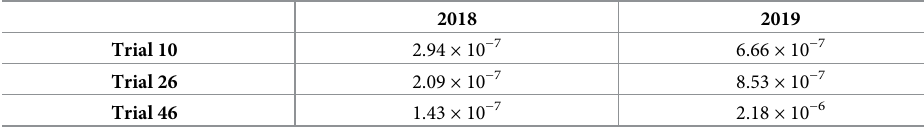
Table 3. RMSEs of the 2018 and 2019 predictions a